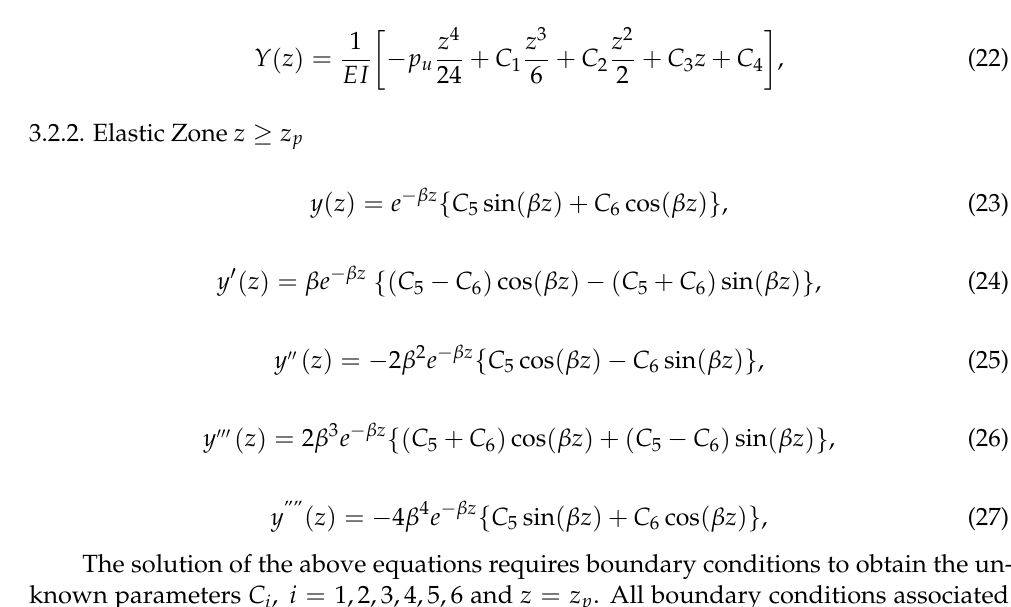
Table 2. The equilibrium for the bending moment and shear force at z = 0 and compatibility for displacement and slope at z = z p is